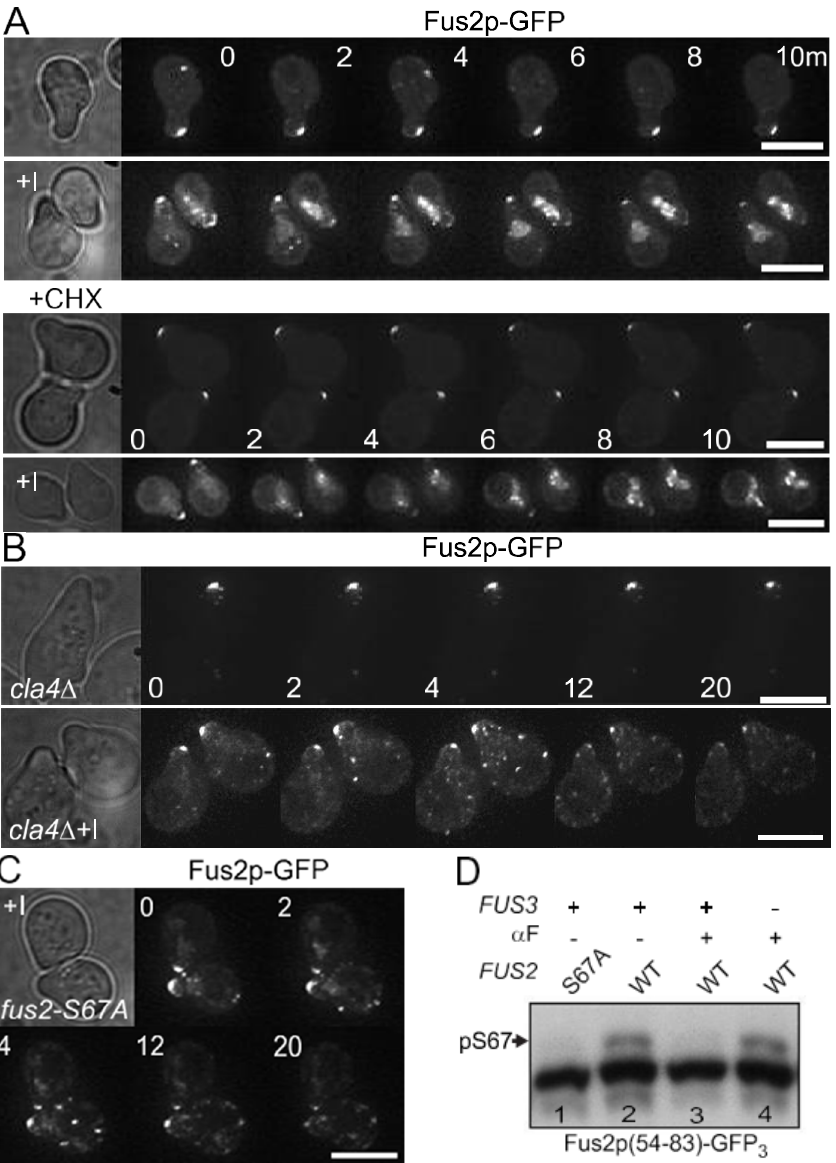
Figure 1. Inhibition of Fus2 ‐ S67 phosphorylation by Fus3p in mating cells. ( A – C ) The localization of Fus2p ‐ GFP was examined over time in fus3 ‐ Q93G ( fus3 ‐ as1 ) as described in the Materials and Methods. Indicated strains were pre ‐ grown in selective medium and induced with α‐ factor for 90 min. Images were collected immediately after addition of the inhibitor (1 ‐ NA ‐ PP1) at t = 0 and at 1 min intervals. Bar, 5 μ m. ( A ) Wild ‐ type (MY15342) containing the fus3 ‐ as1 allele was observed with (+I) and without inhibitor. For the bottom two panels, cycloheximide (CHX) was added to a final concentration of 35 μ g/mL, 15 min before inhibitor treatment. ( B ) A cla4 Δ fus3 ‐ as1 mutant (MY15305) was observed. ( C ) A fus2 ‐ S67A fus3 ‐ as1 mutant (MY15123) was observed. ( D ) Fus2p 54 − 83 ‐ or Fus2p 54 − 83 ‐ S67A ‐ GFP 3 was expressed under control of the GAL1 promoter in FUS3 (MY12553 and MY12300) or fus3 Δ cln3 Δ (MY12282) for 90 min during mitotic growth or after α‐ factor arrest for 2 h. Samples were run on 50 μ M Phos ‐ tag gels and detected by anti ‐ GFP. Arrow indicates the phos ‐ phorylated species (pS67).